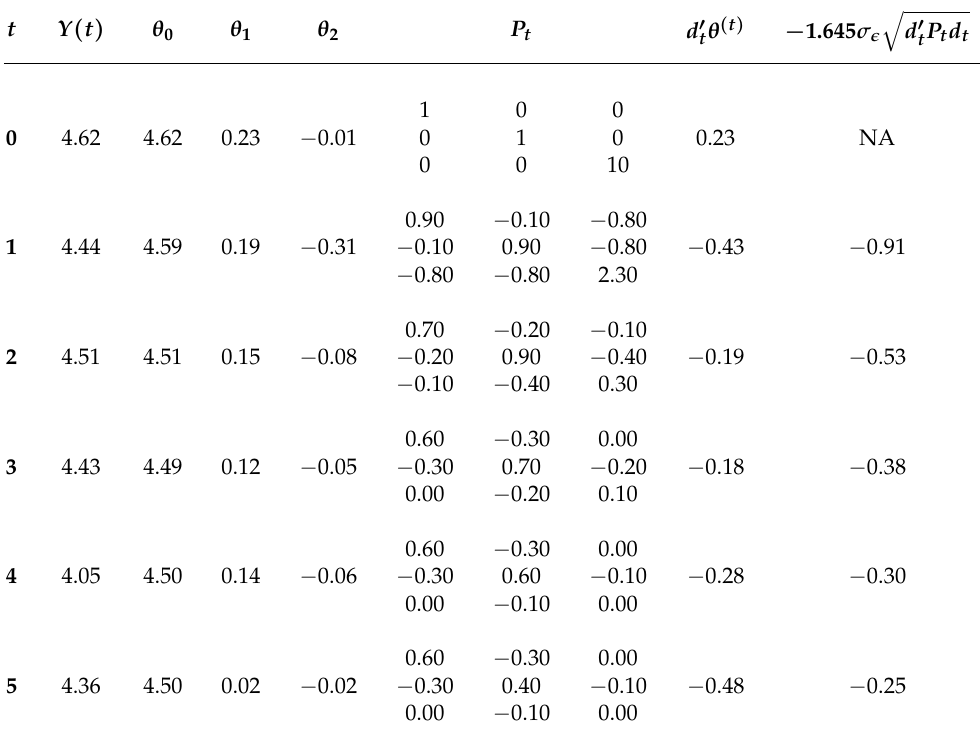
Table 5. Recursive procedure of θ i and P t when t < N −